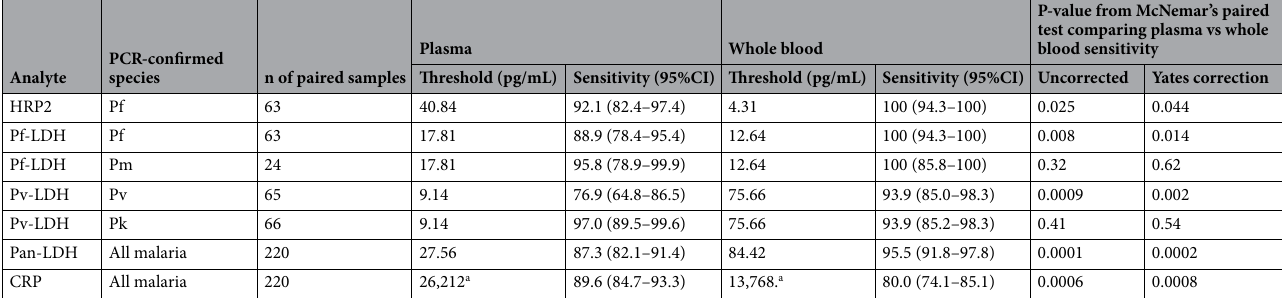
Table 3. Comparison of assay sensitivity in paired plasma and whole blood. PCR polymerase chain reaction, CI confidence interval, Pf Plasmodium falciparum , Pv Plasmodium vivax , Pk Plasmodium knowlesi ,